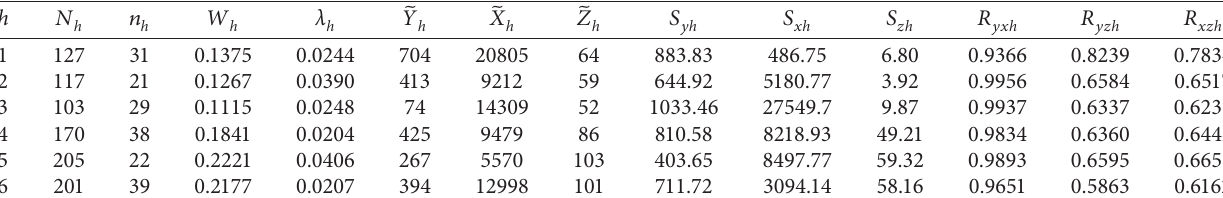
Table 2: Data description of population 1 (scenario I).